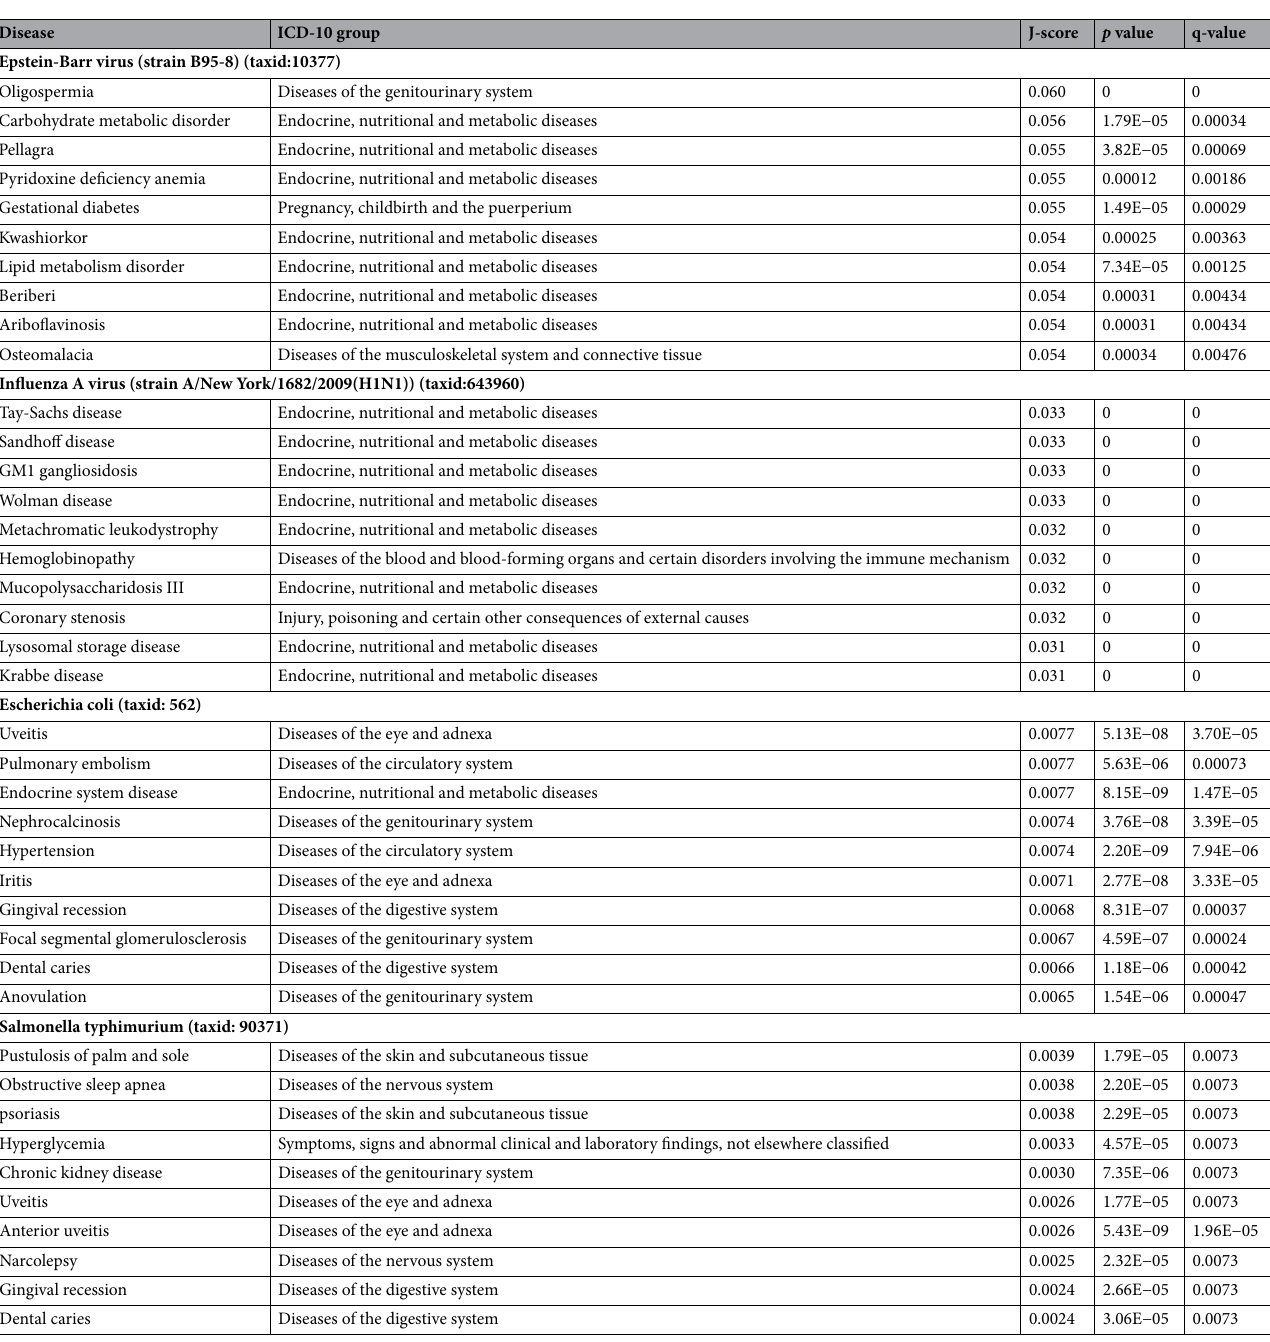
Table 4. Top 10 disease comorbidities associated with 4 common infectious pathogens: Epstein-Barr virus (EBV) (strain B95-8), Influenza A virus (strain A/New York/1682/2009(H1N1)), Escherichia coli (Taxid 562), and Salmonella typhimurium (Taxid